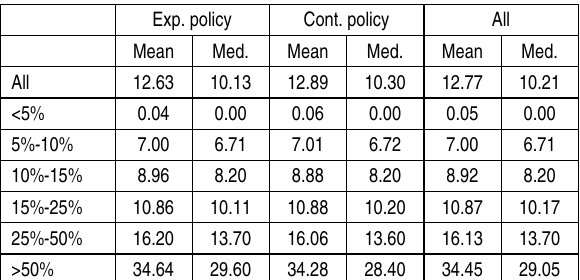
Table 5. The percentage held by the blockholders across monetary policy periods